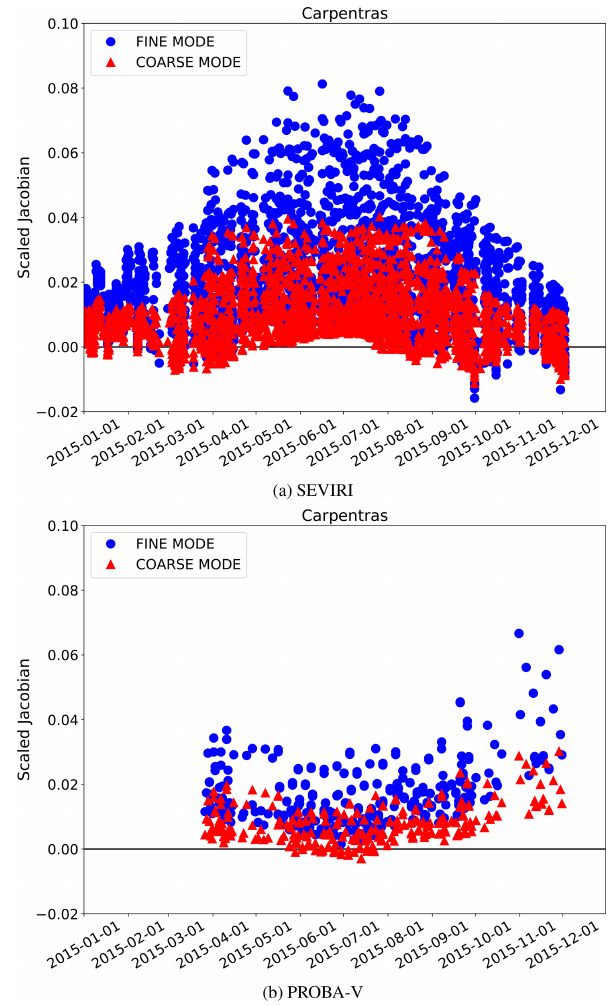
Figure 7. Scaled AOT Jacobians time series over Carpentras, France (vegetated target) related to SEVIRI VIS0.6 band ( a ) and PROBA-V RED band ( b ) observations. The blue dots represent the fine mode and the red triangles the coarse mode.